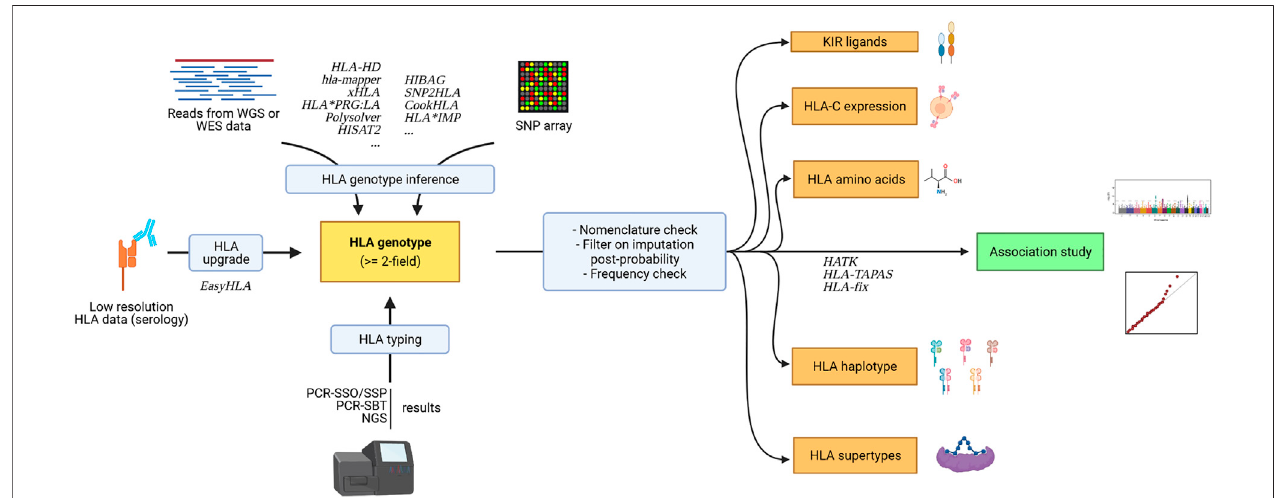
FIGURE 3 | Association study pipeline for HLA data and surrounding immunogenetic factors. Created with